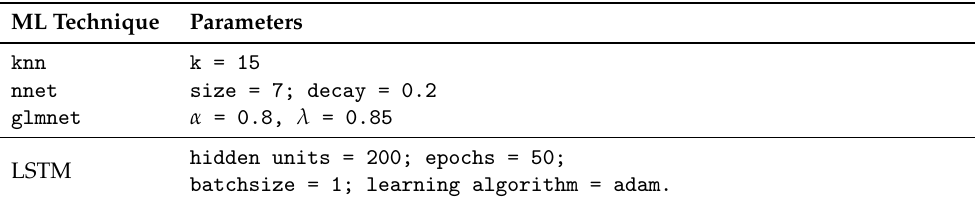
Table 6. Parameters used to perform ML techniques with caret package in R and the Deep Learning Toolbox in